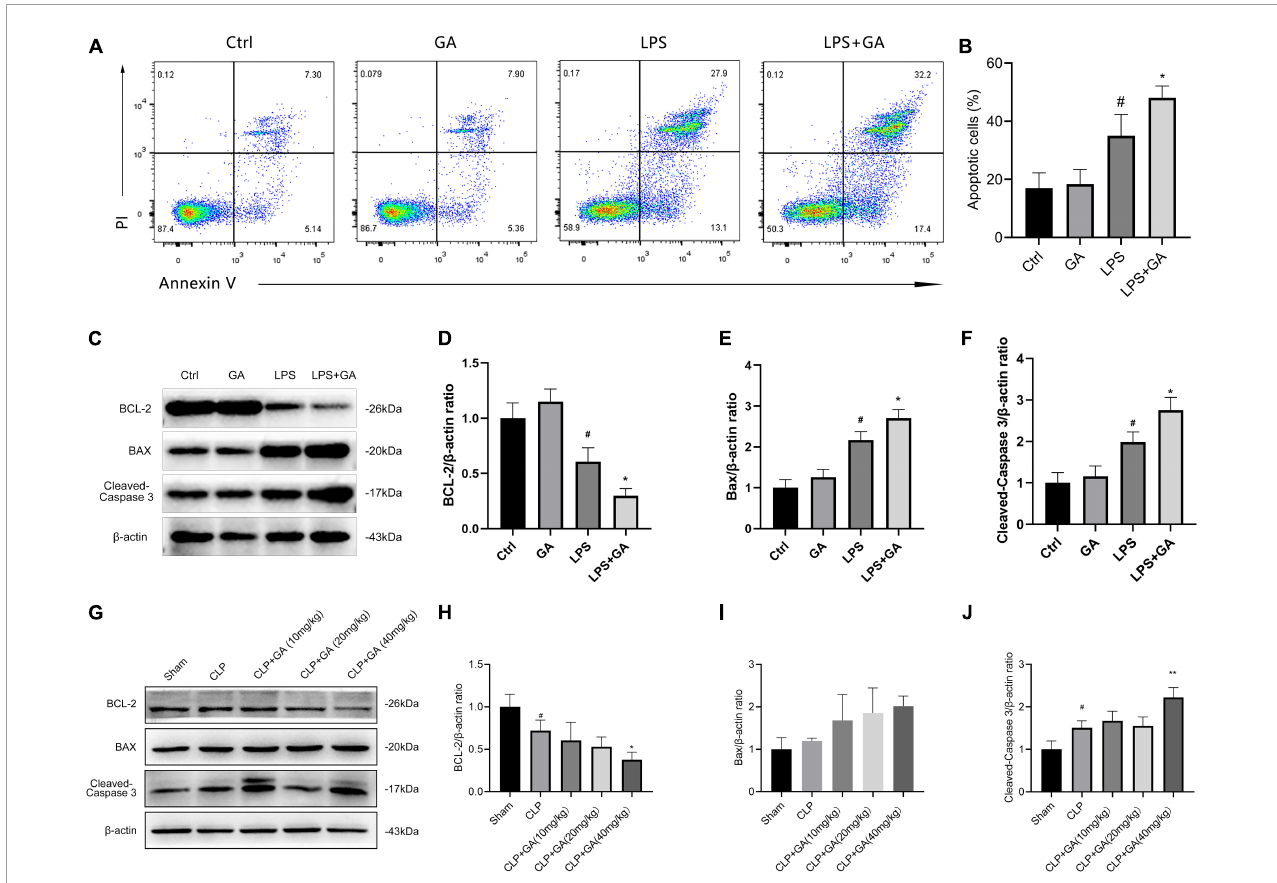
FIGURE6 Ginkgolic acid (GA) exacerbates macrophage apoptosis. (A) Representative flow cytometric pictures of the percentage of apoptotic cells in RAW 264.7 cell at 24 h after the stimulation of lipopolysaccharide (LPS), treated with GA or vehicle ( n = 3). Data were showed with the mean ± SD in (B) . # P < 0.05 versus the Ctrl group; ∗ P < 0.05 versus the LPS group. (C) Representative image of western blotting analysis of BCL2, BAX, and Cleaved-Caspase 3 in RAW 264.7 cell at 24 h after the stimulation of LPS, treated with GA or vehicle ( n = 3). Data were showed with the mean ± SD in (D–F) . # P < 0.05 versus the Ctrl group; ∗ P < 0.05 versus the LPS group. (G) Representative image of western blotting analysis of BCL2, BAX, and Cleaved-Caspase 3 in the PMs of septic mice ( n = 3). Quantification of western blotting data were shown in (H–J) . Data were calculated with the mean ± SD. # P < 0.05 versus the Sham group; ∗ P < 0.05, ∗∗ P < 0.01 versus the CLP